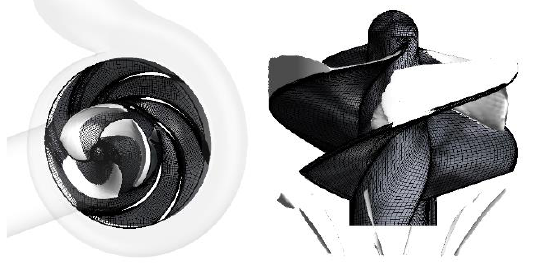
Fig. 10. Vapor volume fraction of value